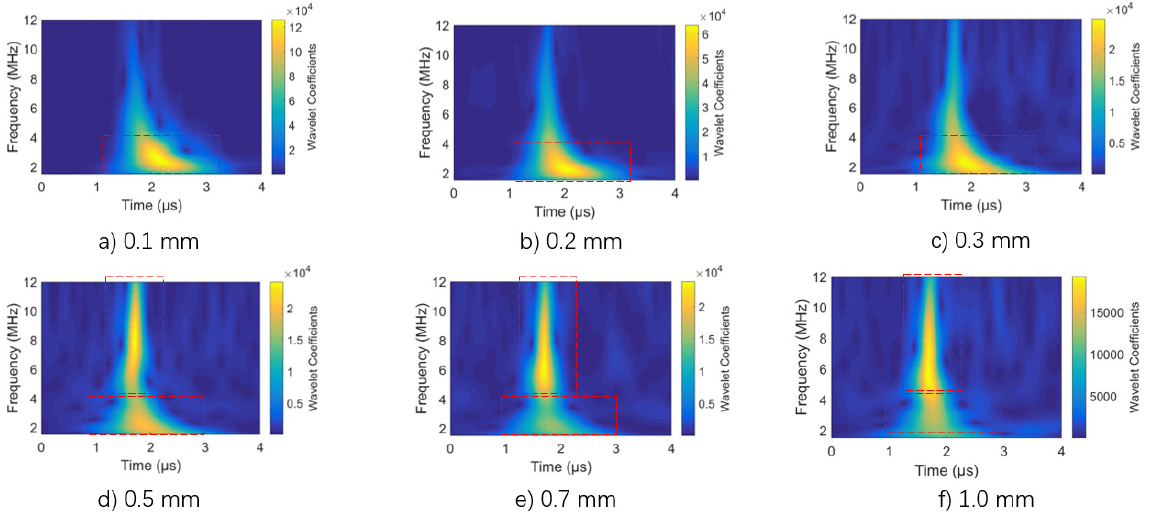
Figure 7. Time − frequency images of six defects with different depths of ( a ) 0.1 mm, ( b ) 0.2 mm, ( c ) 0.3 mm, ( d ) 0.5 mm, ( e ) 0.7 mm, and ( f ) 1.0 mm obtained by the A − scan wavelet ‐ transform.